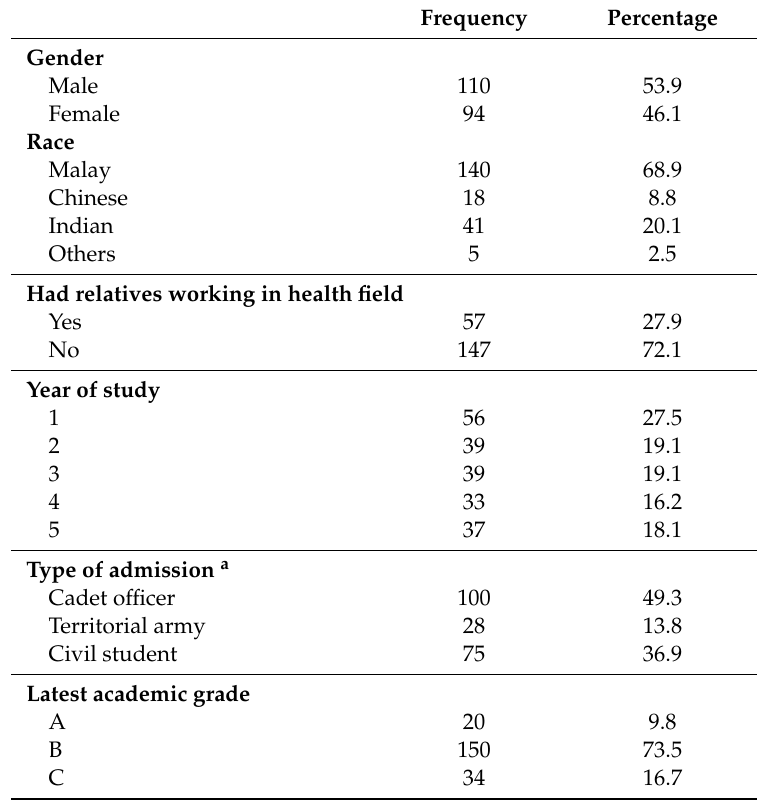
Table 1. Distribution of the respondents’ socio-demographic factors ( n = 204).